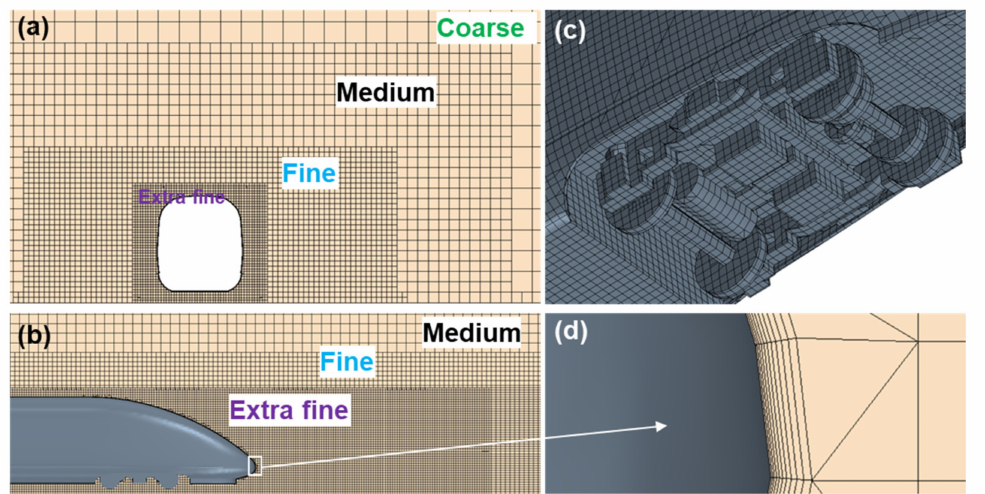
Figure 3. Computational mesh employed in the simulations: ( a ) front view of mesh density in the computational domain; ( b ) side view of mesh density in the computational domain; ( c ) mesh distribution around the bogie; ( d ) the prism layer cells attached to the train surface.